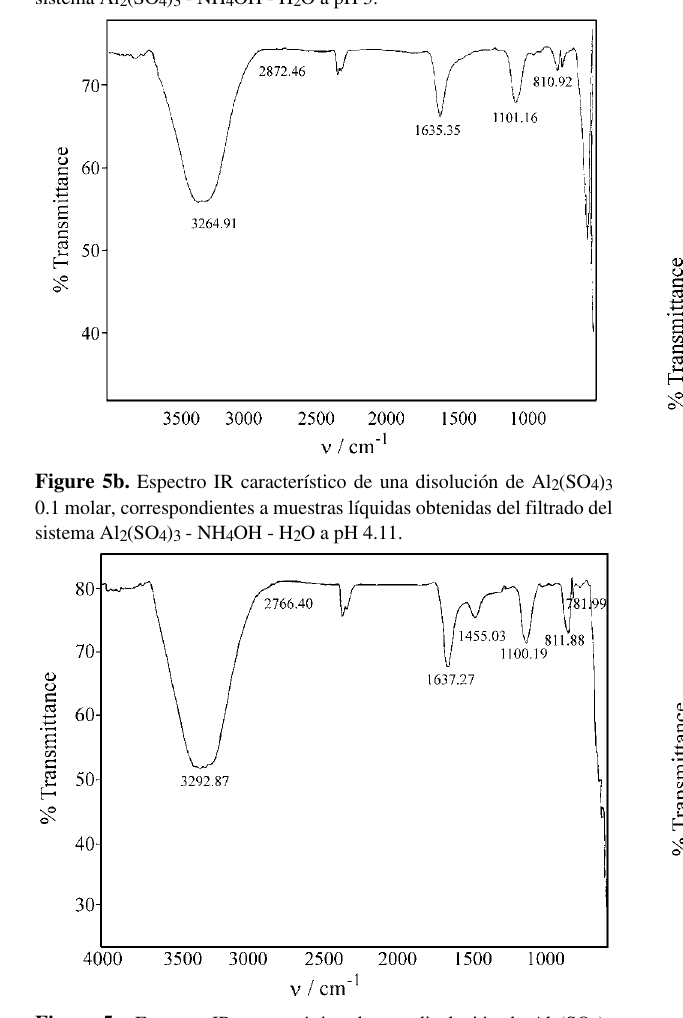
Figure 5a. Espectro IR característico de una disolución de Al 2 (SO 4 ) 3 0.1 molar, correspondientes a la muestra líquida obtenida del filtrado del sistema Al 2 (SO 4 ) 3 - NH 4 OH - H 2 O a pH 3.